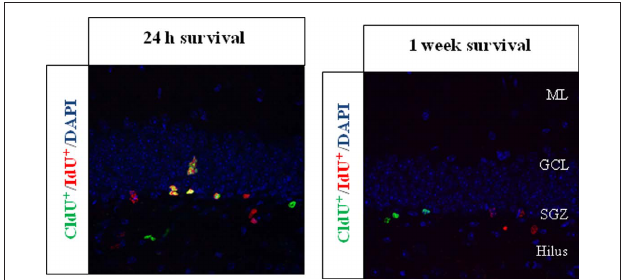
FIgUre 2 | representative pictures of CldU + and IdU + cells in set-up experiments. The thymidine analogs were injected in the same individuals separated by either 24 h or 1 week; BrdU-equimolecular dosages of CldU and IdU were injected. Animals were then sacrificed 2 h after the last injection. We found that the injection of different thymidine analogs separated by more than 1 day (1 week survival) led to no overlapping of the labeling, while in the 24 h experiment a huge proportion of cells were co-labeled, as expected. The labeling was assessed in the hippocampal dentate gyrus of adult mice. The pictures were registered from 50 μm thick coronal sections, and both are taken from Llorens-Martin et al. (2010). ML, molecular layer; GCL, granule cell layer; SGZ, subgranular